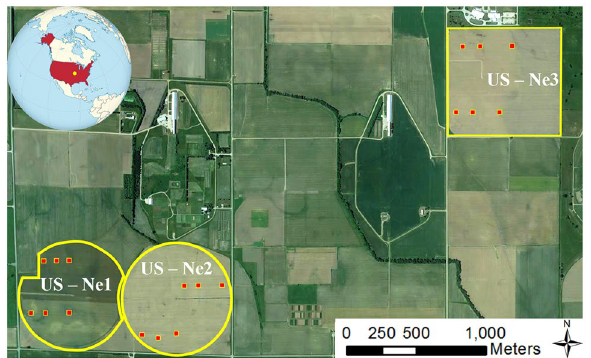
Figure 1. Locations of the three studied maize fields in Nebraska, USA displayed in a true color composite of Maxar imagery from Google Earth collected on June 5, 2018 (Google, Imagery ©2022 Maxar Technologies, U.S. Geological Survey, USDA Farm Service Agency, Map data ©2022). These included irrigated fields US-Ne1 and US-Ne2 and the non-irrigated US-Ne3 field (yellow outlines). The red squares identify each of the intensive measurement zones, where plants were collected for LAI measurements. Software used to produce the map: ArcGIS version 10.8.1 (www. esri. com/ en- us/